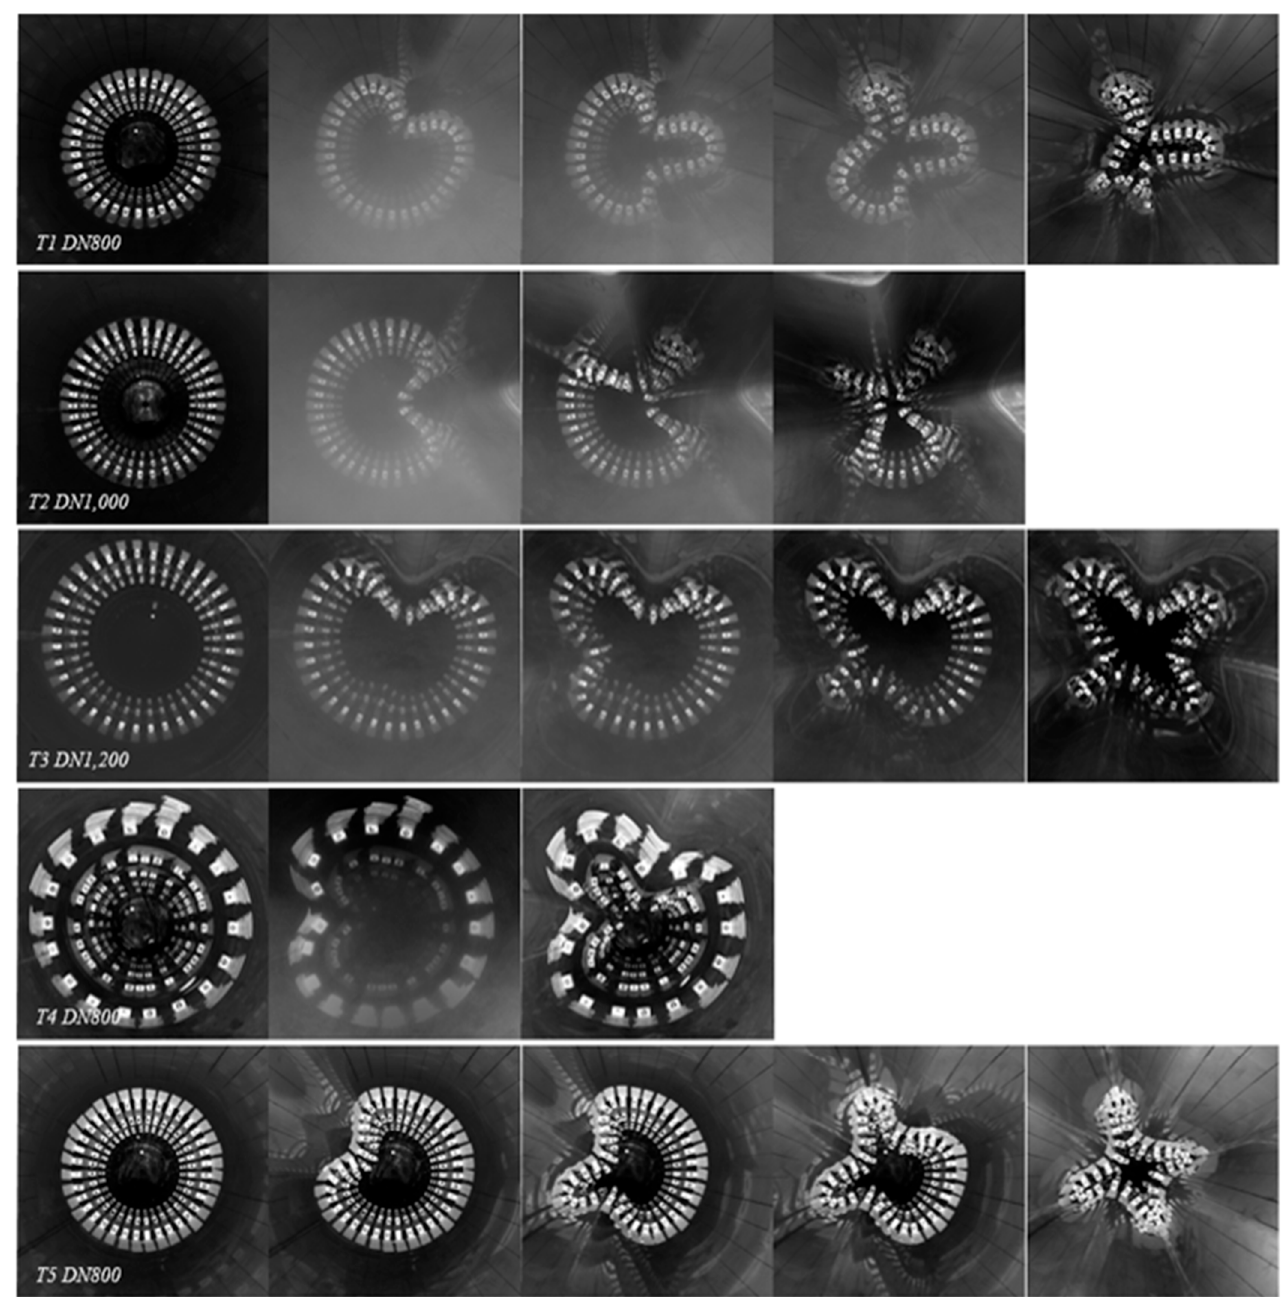
Figure 5. Visual CCD image of buckling